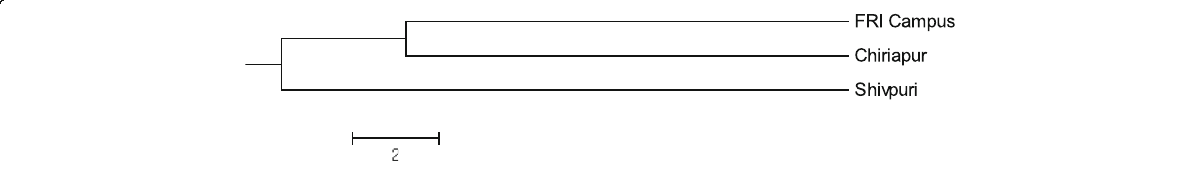
Fig. 9 Dendrogram based Nei ’ s genetic distance among three growth forms of Dendrocalamus